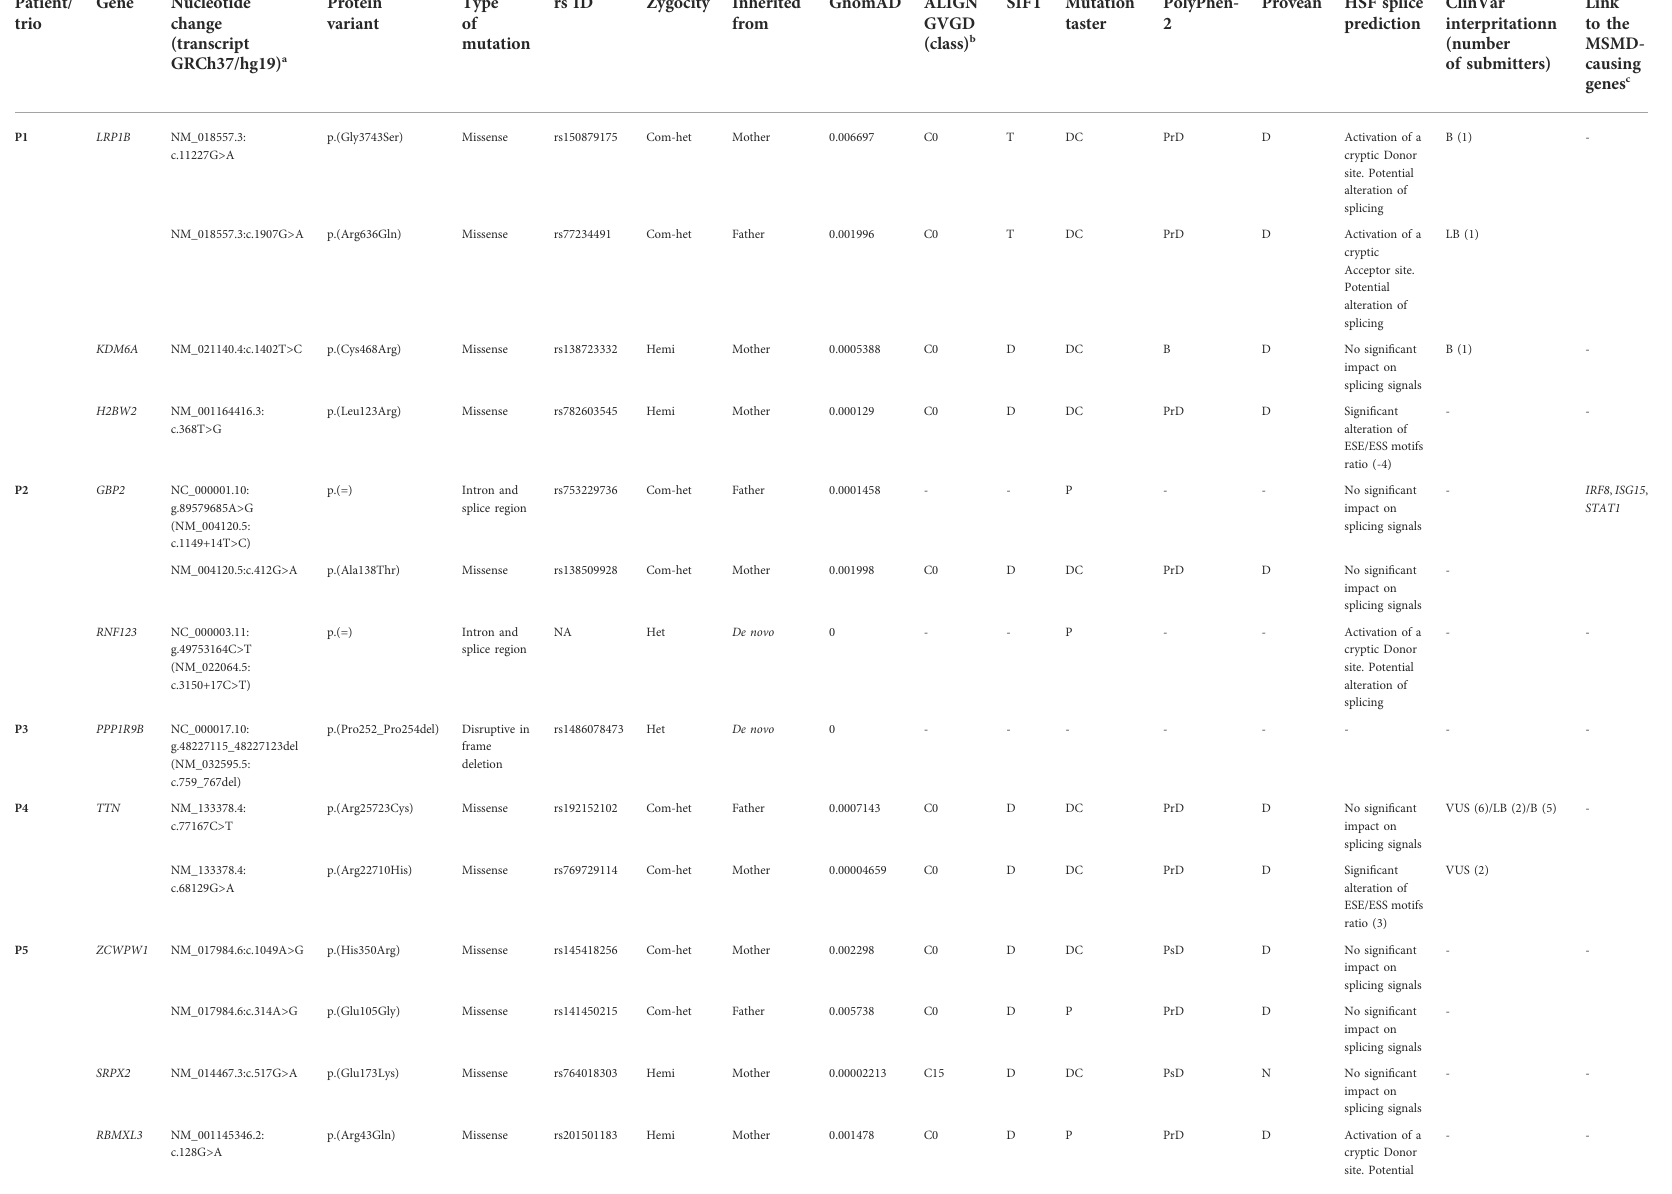
TABLE 3 Candidate rare variants (MAF < 0.01) identi fi ed in the seven MD trio probands. Patient/